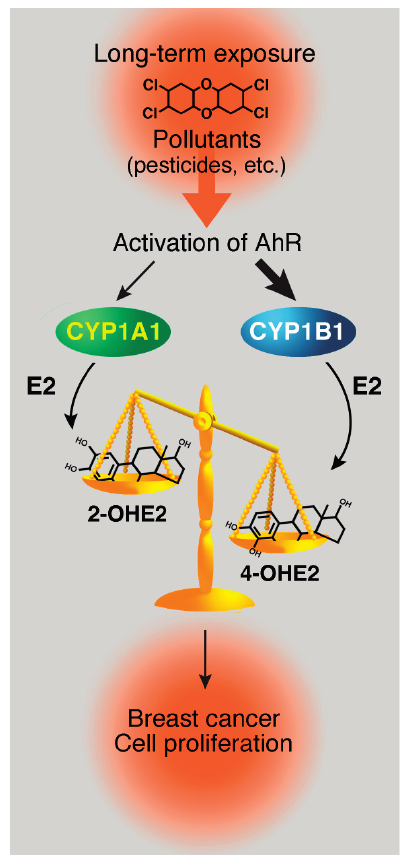
Figure 1. Proposed model for initiation of breast cancer by pollutants and pesticides. Long-term exposure to pollutants and pesticides, which could induce the aryl hydrocarbon receptor (AhR) and the estrogen receptor α (ER α ) signaling pathways, will create an imbalance between CYP1A1 and CYP1B1 enzymes. Thus, this will modify the 2-OHE2/4-OHE2 ratio and could contribute to mammary